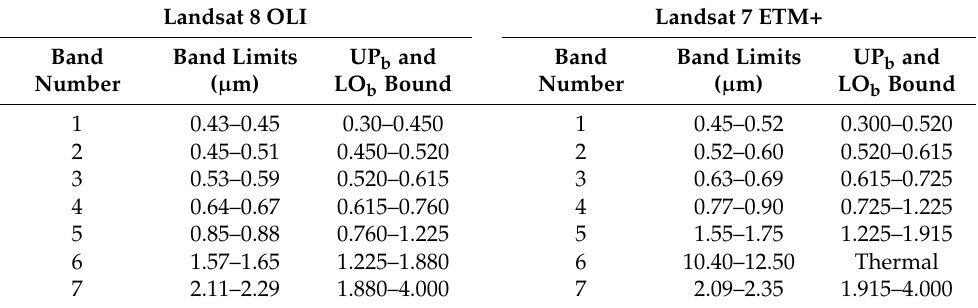
Table 3. Landsat 8 OLI and Landsat 7 ETM+ band width and UP b and LO b in Equation (5).